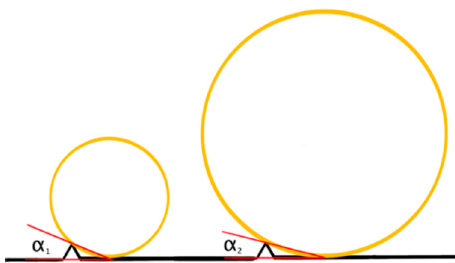
Figure 9. Attack angles of tires with different tire diameters ( α 1 > α 2 ).